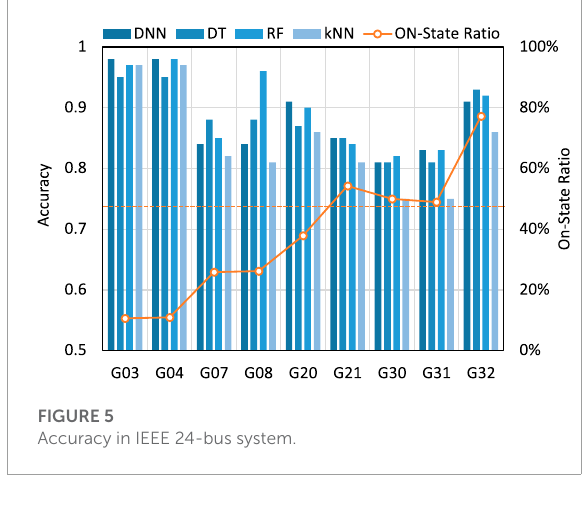
TABLE 3 Precision and recall in IEEE 24-bus